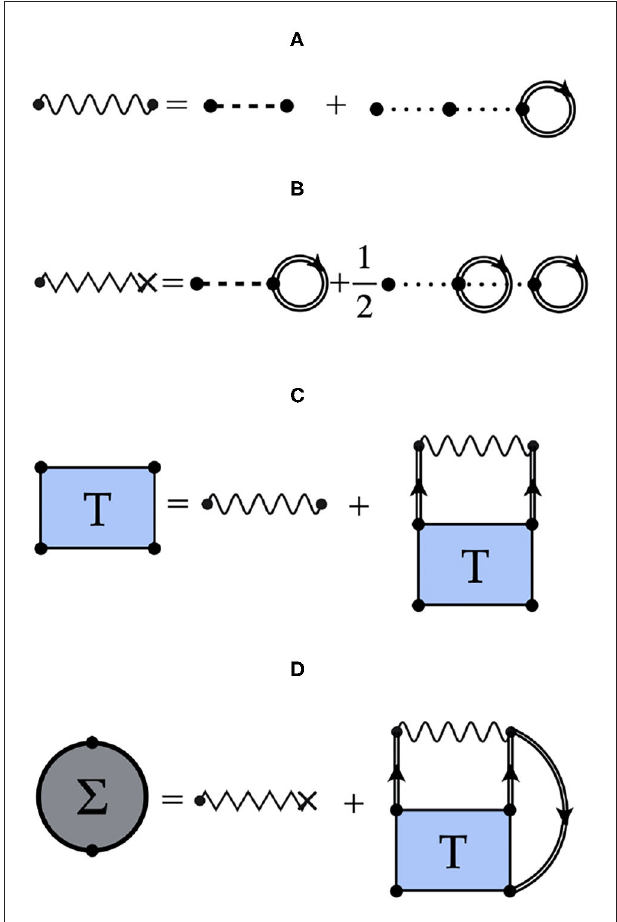
FIGURE 1 | Diagrammatic representation of the ladder approximation to the self-energy, 6 , including three-nucleon interactions. Diagram (A) describes the two-body effective interaction (wiggly line) obtained from the sum of the two-body interaction V (dashed line) and an averaged three-nucleon force W (dotted line). Diagram (B) shows the one-body effective interaction. Diagram (C) provides the self-consistent equation for the T − matrix. Finally, diagram (D) represents the two components of the self-energy: an energy-independent one-body effective interaction, and a dispersive contribution arising from the T −